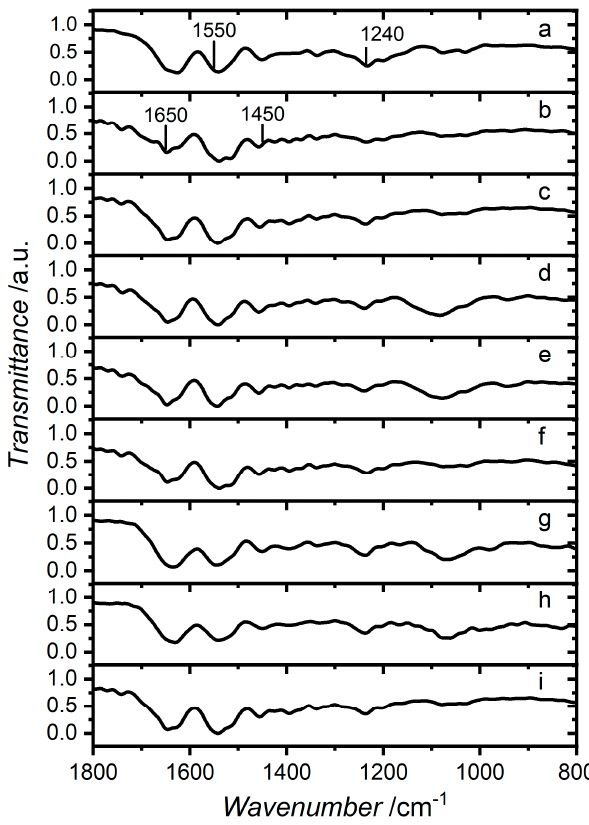
Figure 4. ATR–FTIR spectra of native collagen samples ( a – c ), 4VBC-functionalised collagen samples ( d – f ), and UV-cured collagen samples ( g – i ). ( a ) BA; ( b ) PA; ( c ) CRT; ( d ) B-4VBC; ( e ) P-4VBC;